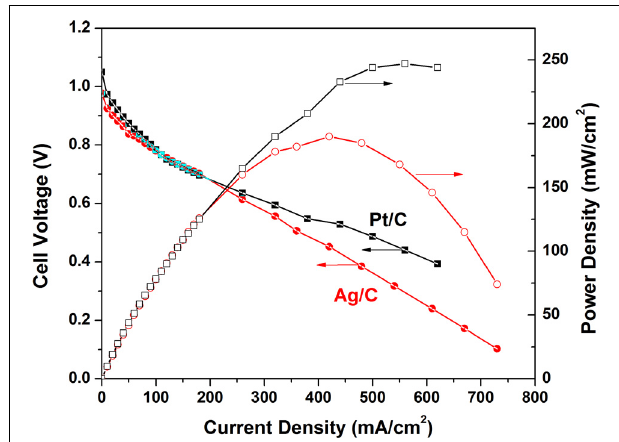
FIGURE 3 | Polarization and power density curves of anion exchange membrane fuel cells. Anode: Pt/C, 0.2 mg Pt /cm 2 ; cathode: Ag/C (self-prepared, 1.0 mg Ag /cm 2 ), or Pt/C (BASF-Fuel Cell, 0.5 mg Pt /cm 2 ); membrane: A201 (Tokuyama); cell temperature: 80 ◦ C; relative humidity of anode and cathode: 100%; flow rate of H 2 and O 2 : 200ml/min; backpressure of anode and cathode: 30 psi.